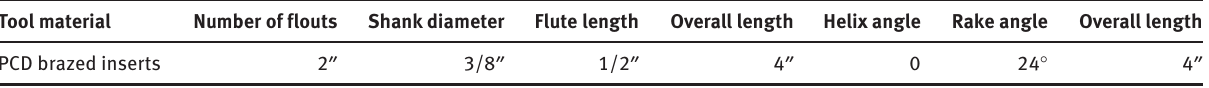
Table 1: Description of tool geometries.